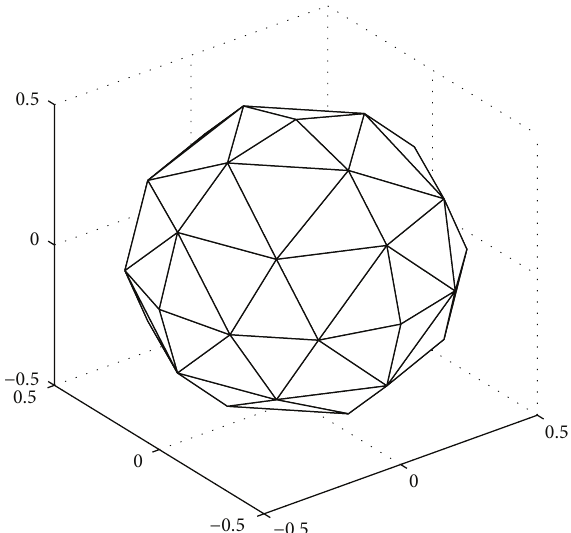
Figure 1: Illustration of the triangular-cell sphere models used in the analysis. This model contains 72 flat cells.